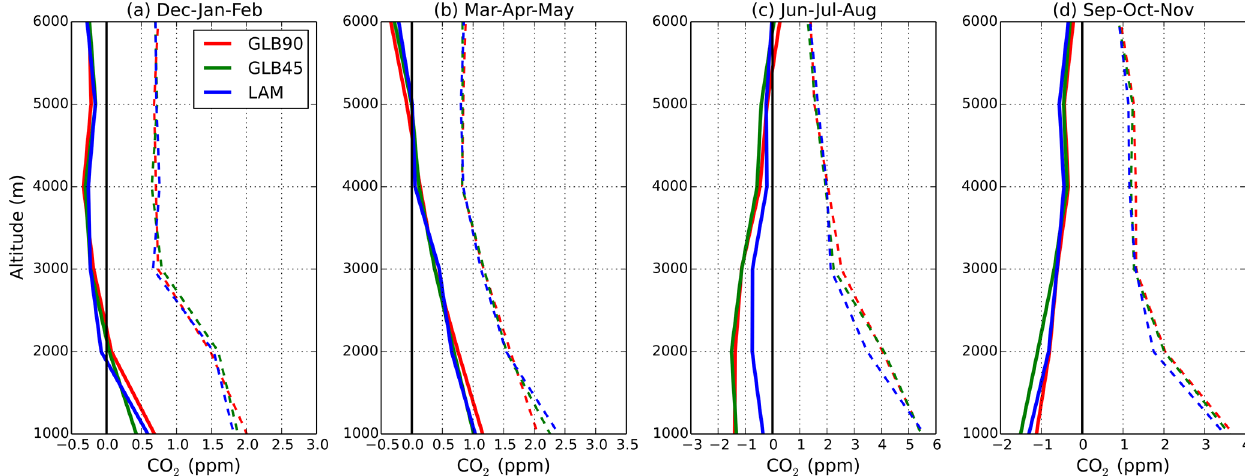
Figure 11. Comparison of profiles of modelled CO 2 concentrations from the GLB90 (red), GLB45 (green) and LAM (blue) experiments to NOAA aircraft observations for (a) January to February and December 2015, (b) March to May 2015, (c) June to August 2015, and (d) September to November 2015. Solid line denotes mean bias and dashed line denotes standard error. The sites used are as follows: Briggsdale, Colorado; Cape May, New Jersey; Dahlen, North Dakota; Estevan Point, British Columbia; East Trout Lake, Saskatchewan; Homer, Illinois; Park Falls, Wisconsin; Worcester, Massachusetts; Poker Flat, Alaska; Charleston, South Carolina; Southern Great Plains, Oklahoma; Sinton, Texas; Trinidad Head, California; West Branch,